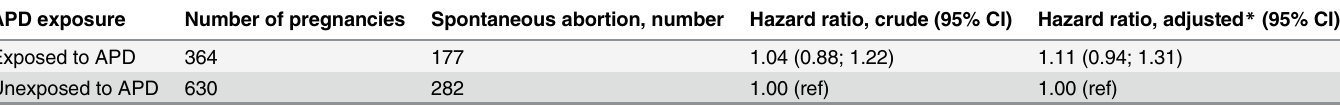
Table 3. Association between the use of APD and SA in pregnancies in 323 women having had at least two pregnancies and at least one abortion. APD